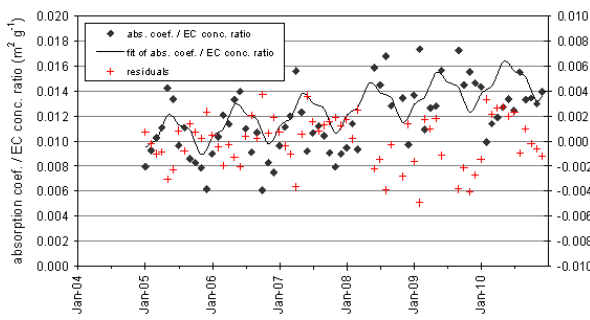
Figure 8. Variations in the aerosol absorption coefficient at 520nm at 0% RH over EC concentration ratio at IPR: monthly mean values (diamonds), least mean square fit of the monthly mean values (line), and residuals